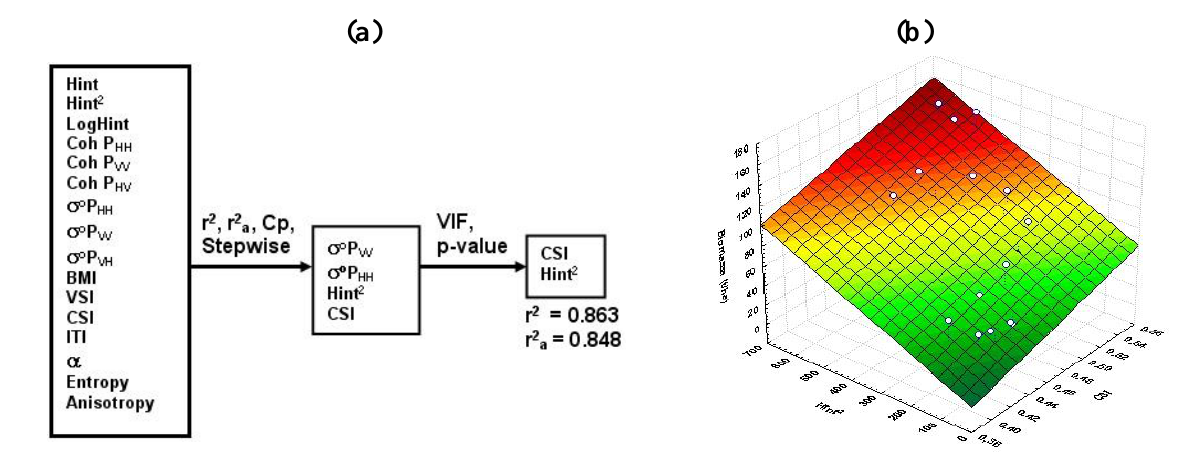
Figure 11. (a) Flow diagram of variables selection; (b) biomass regression model